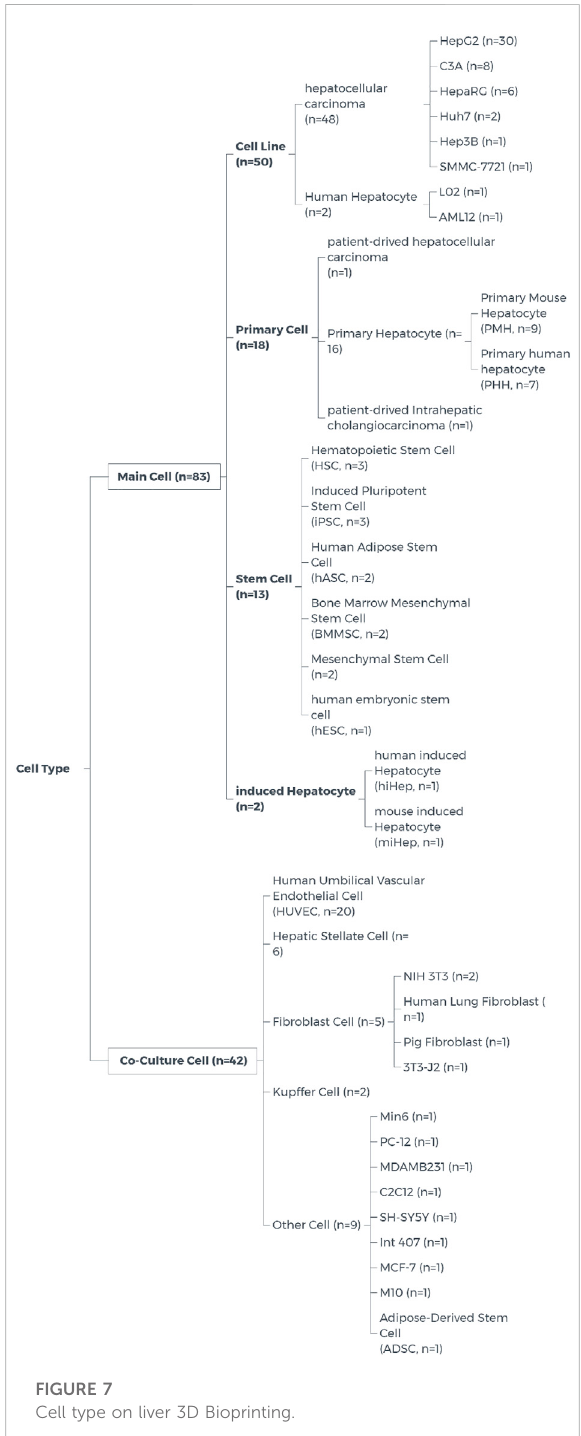
FIGURE 7 Cell type on liver 3D